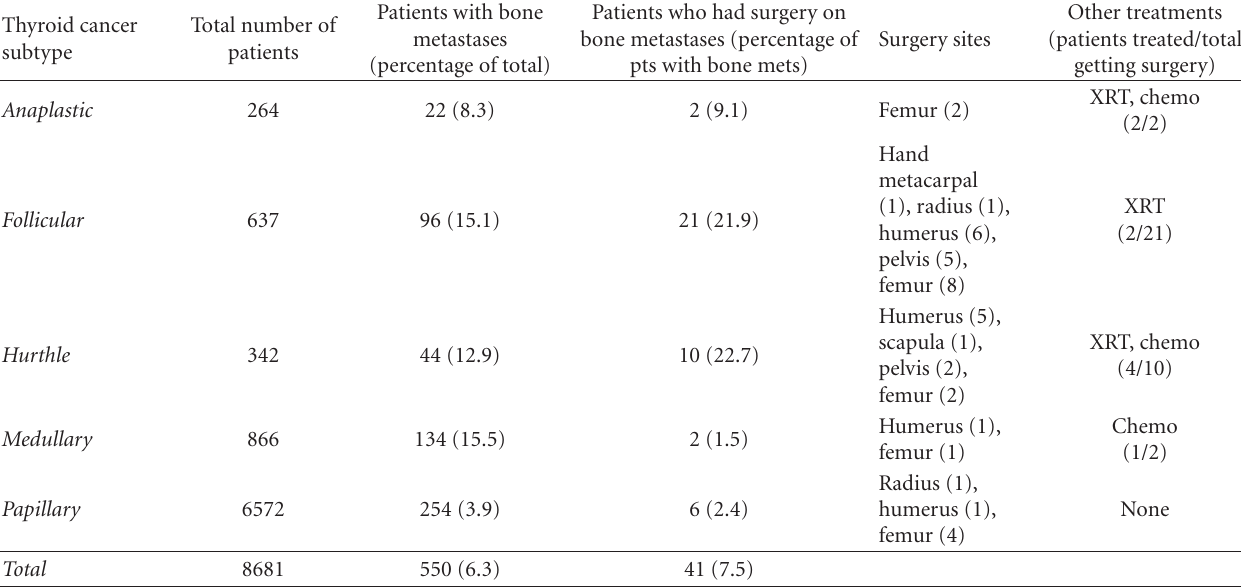
Table 3: Thyroid cancer diagnosis subtypes, bone metastases, and bone surgery